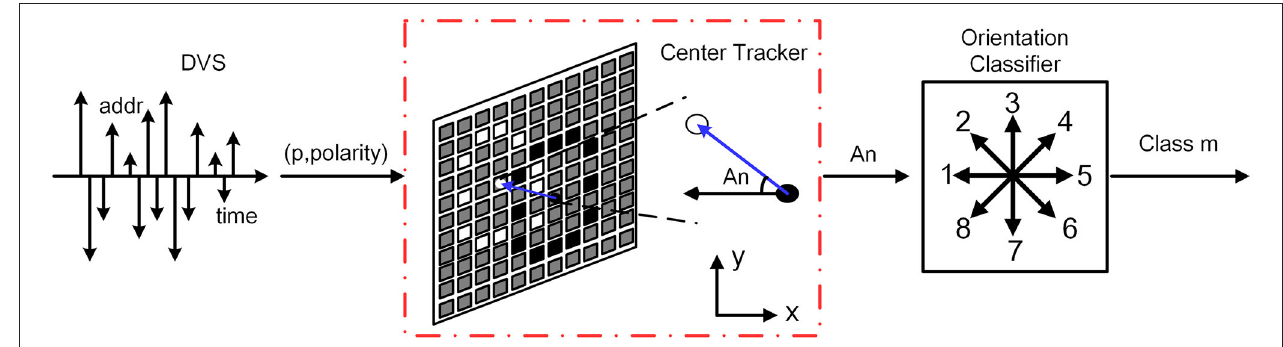
FIGURE 4 | The procedure of center tracking and orientation detection. The events first flow into the center tracking unit to calculate the centers of ON and OFF events and obtain the angle An . And then the orientation classifier categorizes the angle An into the nearest class m . m represents the number of categories which is from 1 to 8.